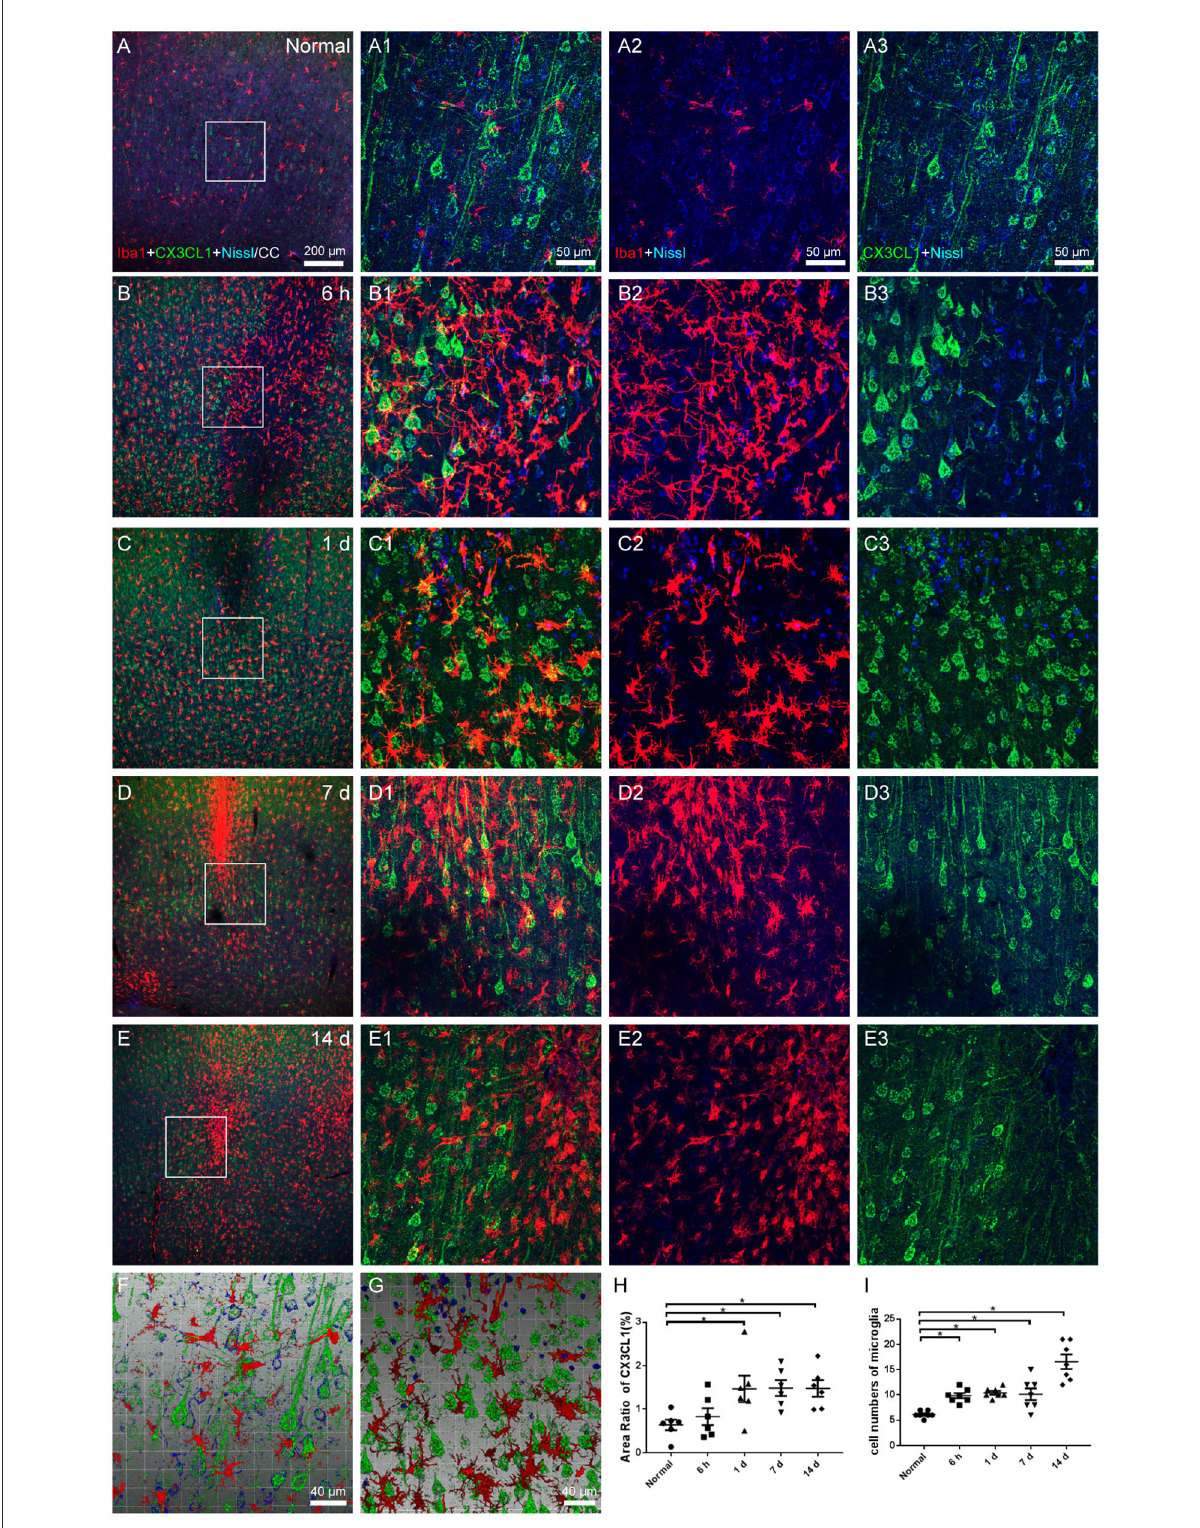
FIGURE6 Microglial and CX3CL1 alteration in cerebral cortex. (A–E) The representative photographs from the cerebral cortex in groups of normal, 6h, 1, 7, and 14 days, showing the Iba1 (red, Alexa Fluor 594)-labeled microglia and CX3CL1 (green, Alexa Fluor 488)-labeling. (A1–E1)